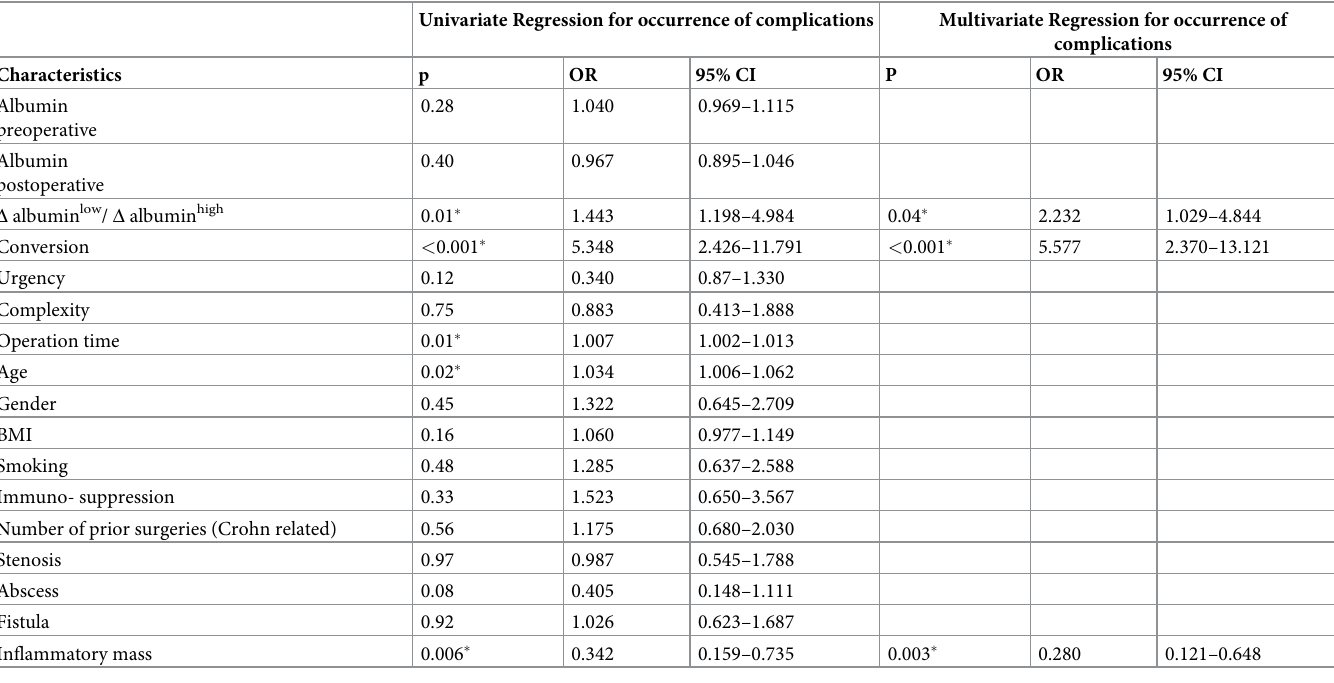
Table 3. Univariate analysis for complications according to basic characteristics and multivariate analysis with stepwise forward